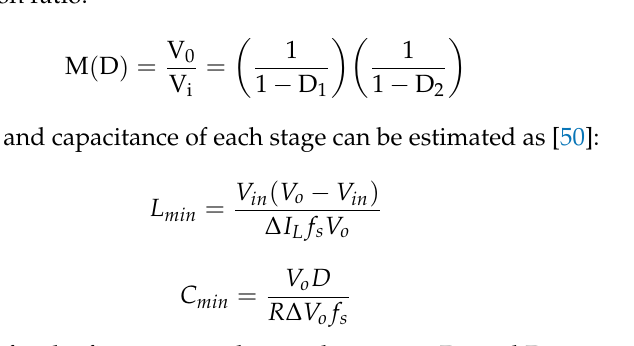
Table 3. Specifications of the first stage.